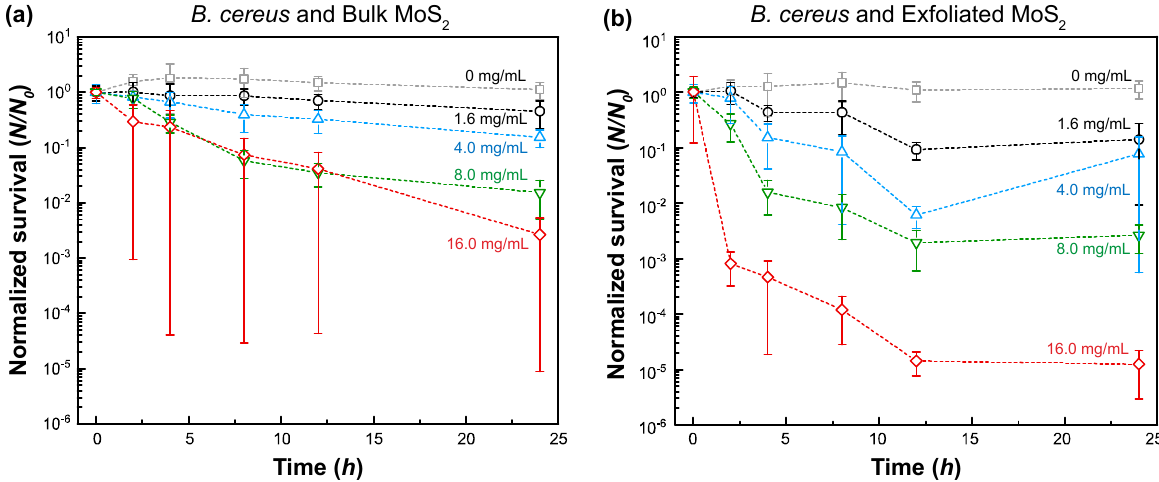
Figure 2. ( a ) Scanning electron microscopy image of bulk MoS 2 , ( b ) atomic force microscopy image of 2D MoS 2 nanosheets, and ( c ) zeta potential of bulk and exfoliated MoS 2 .